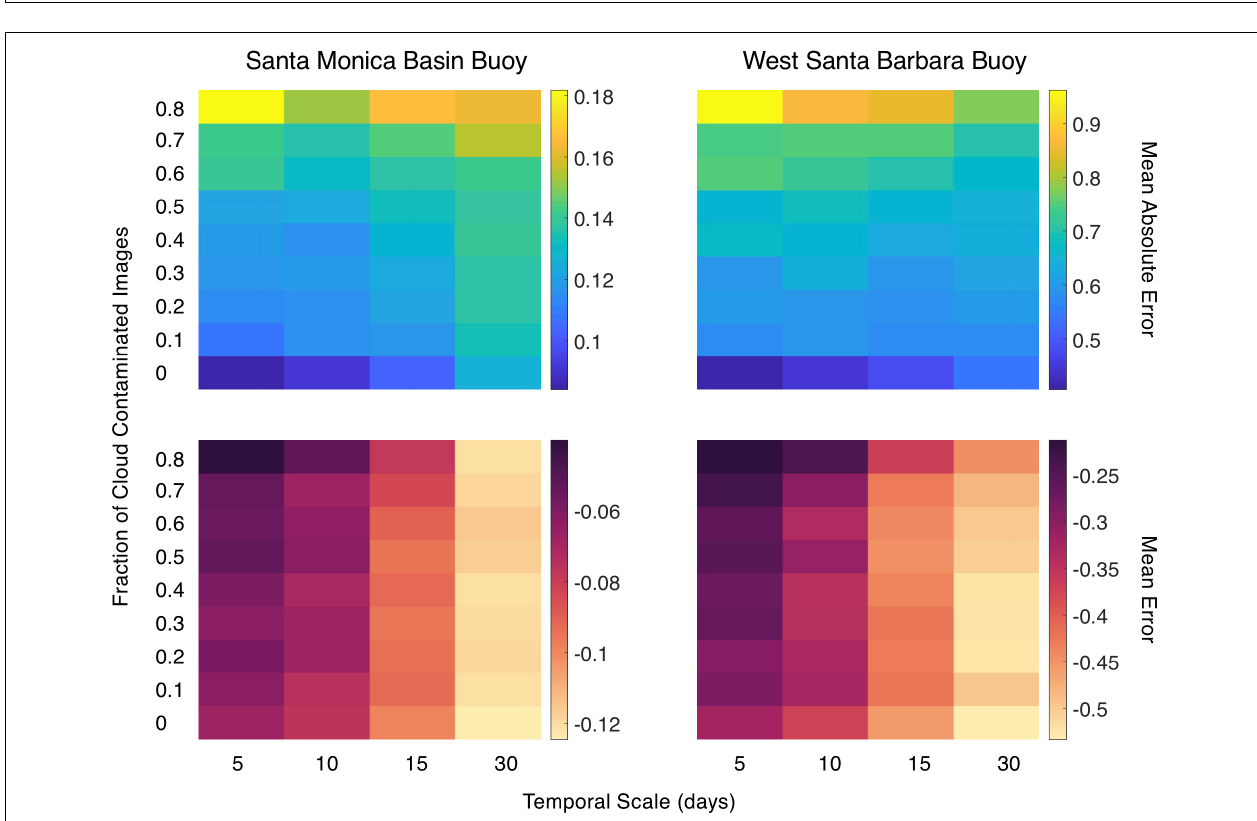
FIGURE 10 | Mean absolute error and mean error in estimated nitrate concentration ( µ mol L − 1 ) as a function of the temporal resolution of the simulated SST imagery and the fraction of daily temperature images contaminated with cloud cover.